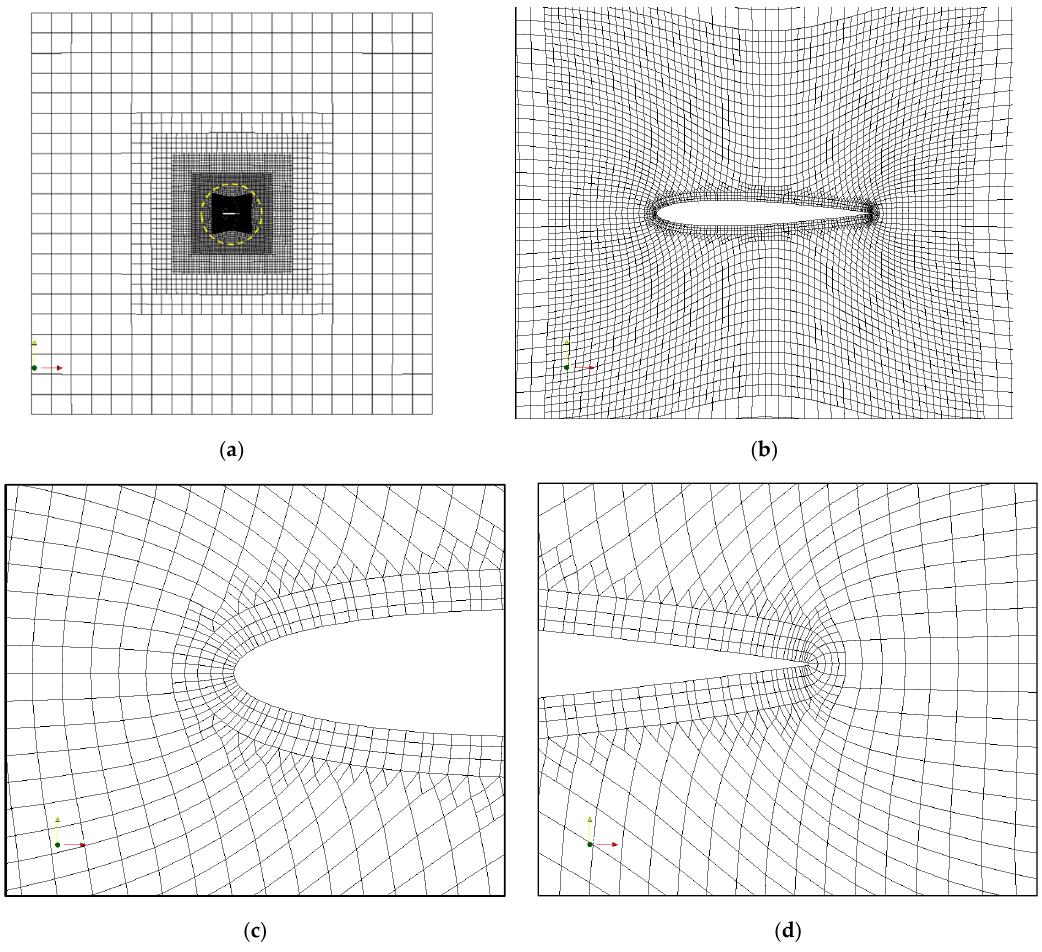
Figure 6. Deformed mesh using the RBF method with additional control points. ( a ) whole domain (side view), ( b ) near body (side view), ( c ) around leading edge (side view), ( d ) around trailing edge (side view).